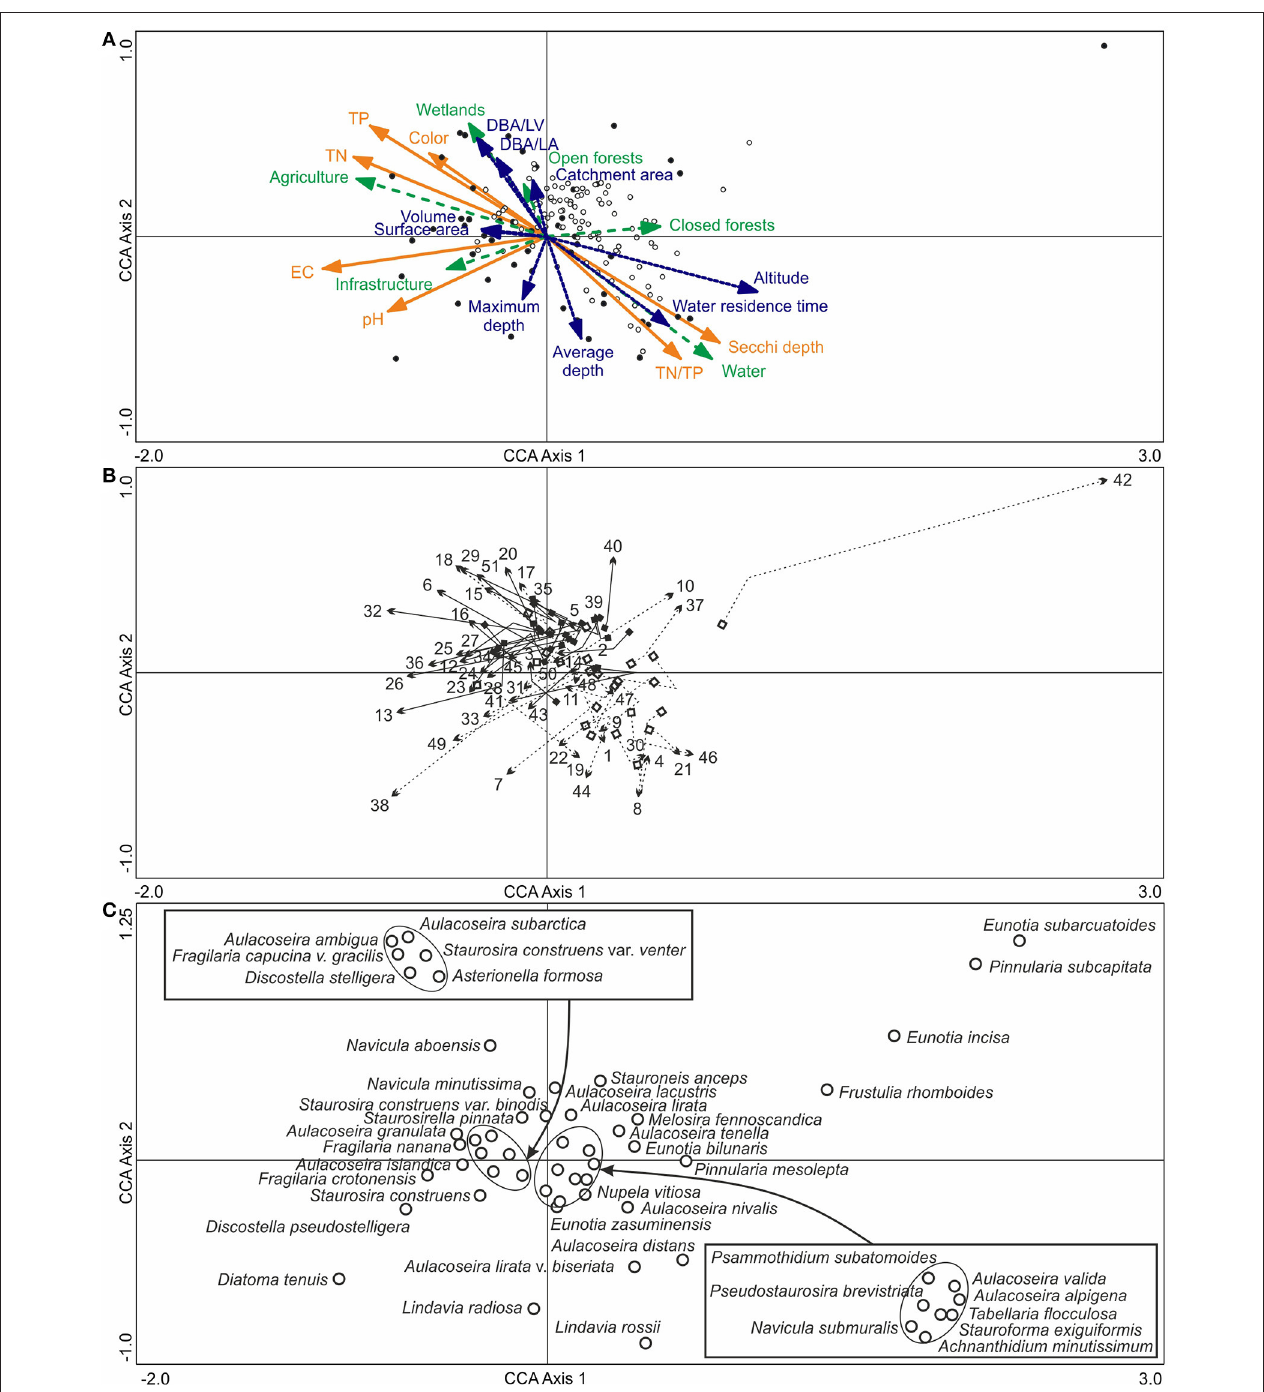
FIGURE 7 | (A) A CCA ordination of the surface diatom samples (filled circles) and modern water quality (orange arrows with solid lines), based on the training set by Tammelin et al. (2017), with the bottom samples (empty circles) plotted passively on top of the ordination. Basin characteristics (blue arrows with dotted lines) and modern catchment land use (green arrows with dashed lines) were added into the ordination as supplementary variables. (B) The pre- to post-human disturbance (bottom to top) trajectories of the sampling sites with squares representing the lower bottom samples and arrowheads the surface sediment samples. The Iisalmi Route sites are marked with solid arrow lines and filled squares and the sites in the adjacent watercourses with dotted arrow lines and empty squares. (C) The top sample diatom taxa (empty circles) with maximum abundances over 5% in the bottom and top samples. The names of the diatom taxa encircled in the center of the ordination are given in the boxes. One small naviculoid species was excluded from the figure as it plotted far from the other taxa in the top right corner of the ordination. See Table 1 for the names and locations of the sampling sites (numbers) and Tammelin et al. (2017) for the description of the modern training set data.